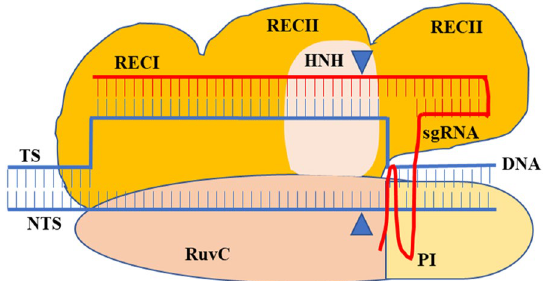
Fig. 2 sgRNA-DNA complexed with multiple domains of Cas9